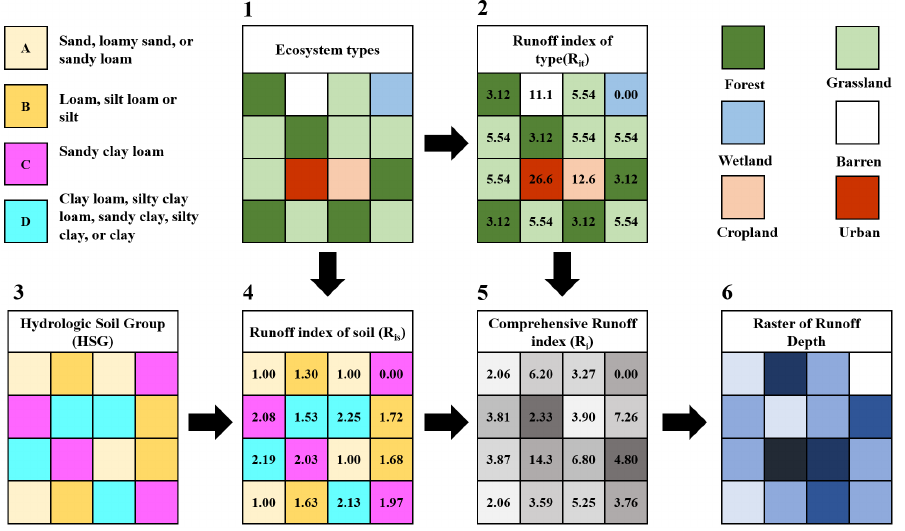
Figure 3. Schematic diagram of the logic principle.